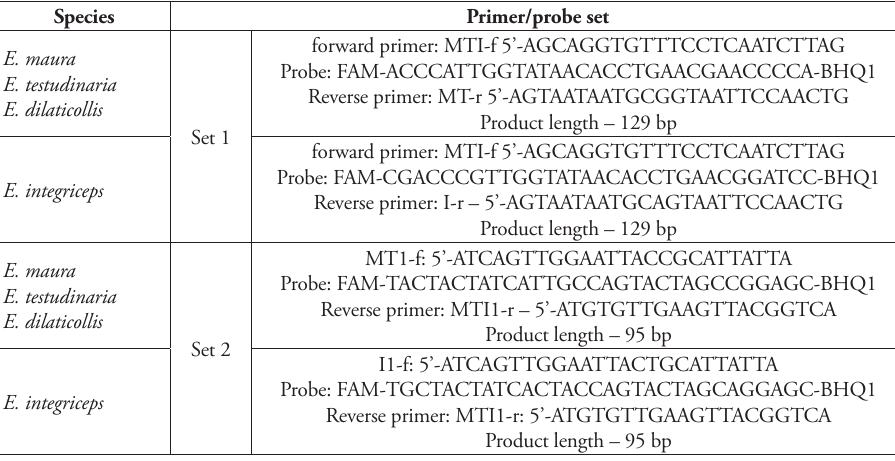
Table 4. Primer/probe set for species identification. Species